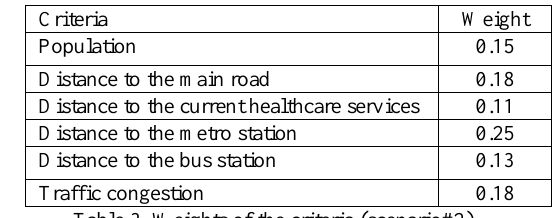
Table 3. Weights of the criteria (scenario#2)